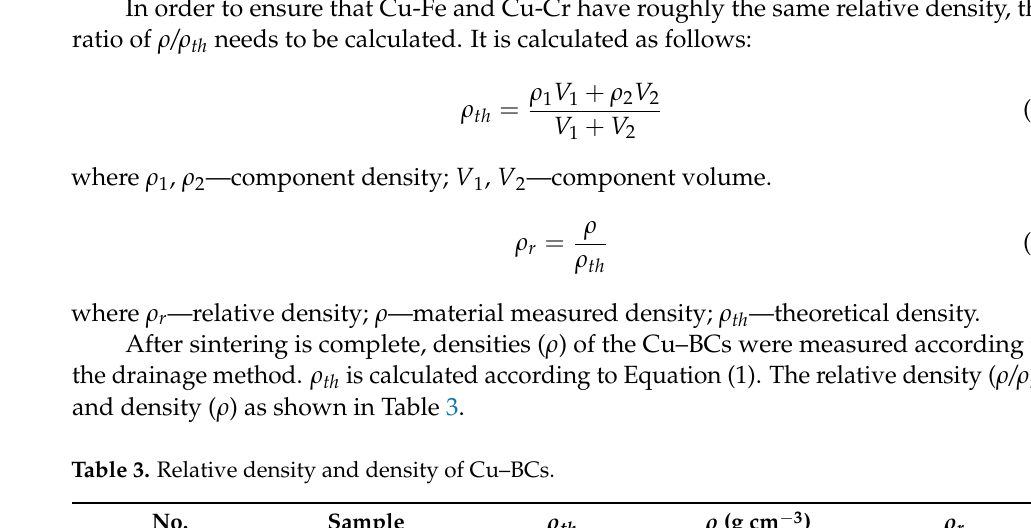
Figure 1. Preparation process for Cu–BCs. Table 3. Relative density and density of Cu–BCs.